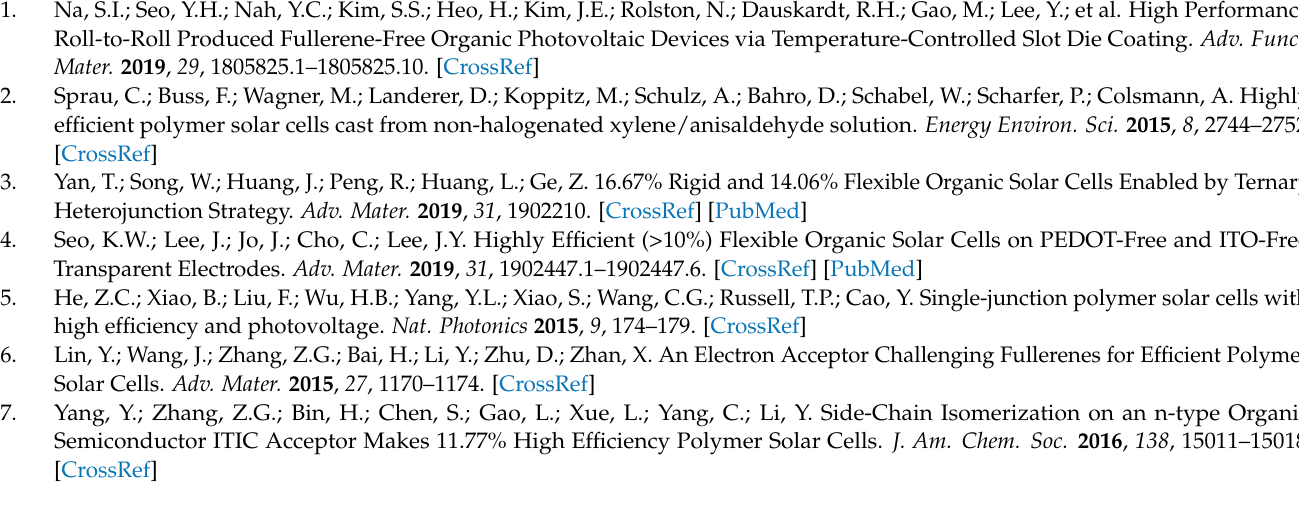
Figure S2: 1 H of compound IDTz-BARO (r.t., in CDCl 3 ); Figure S3: 1 H of compound IDTz-BARS (r.t., in CDCl 3